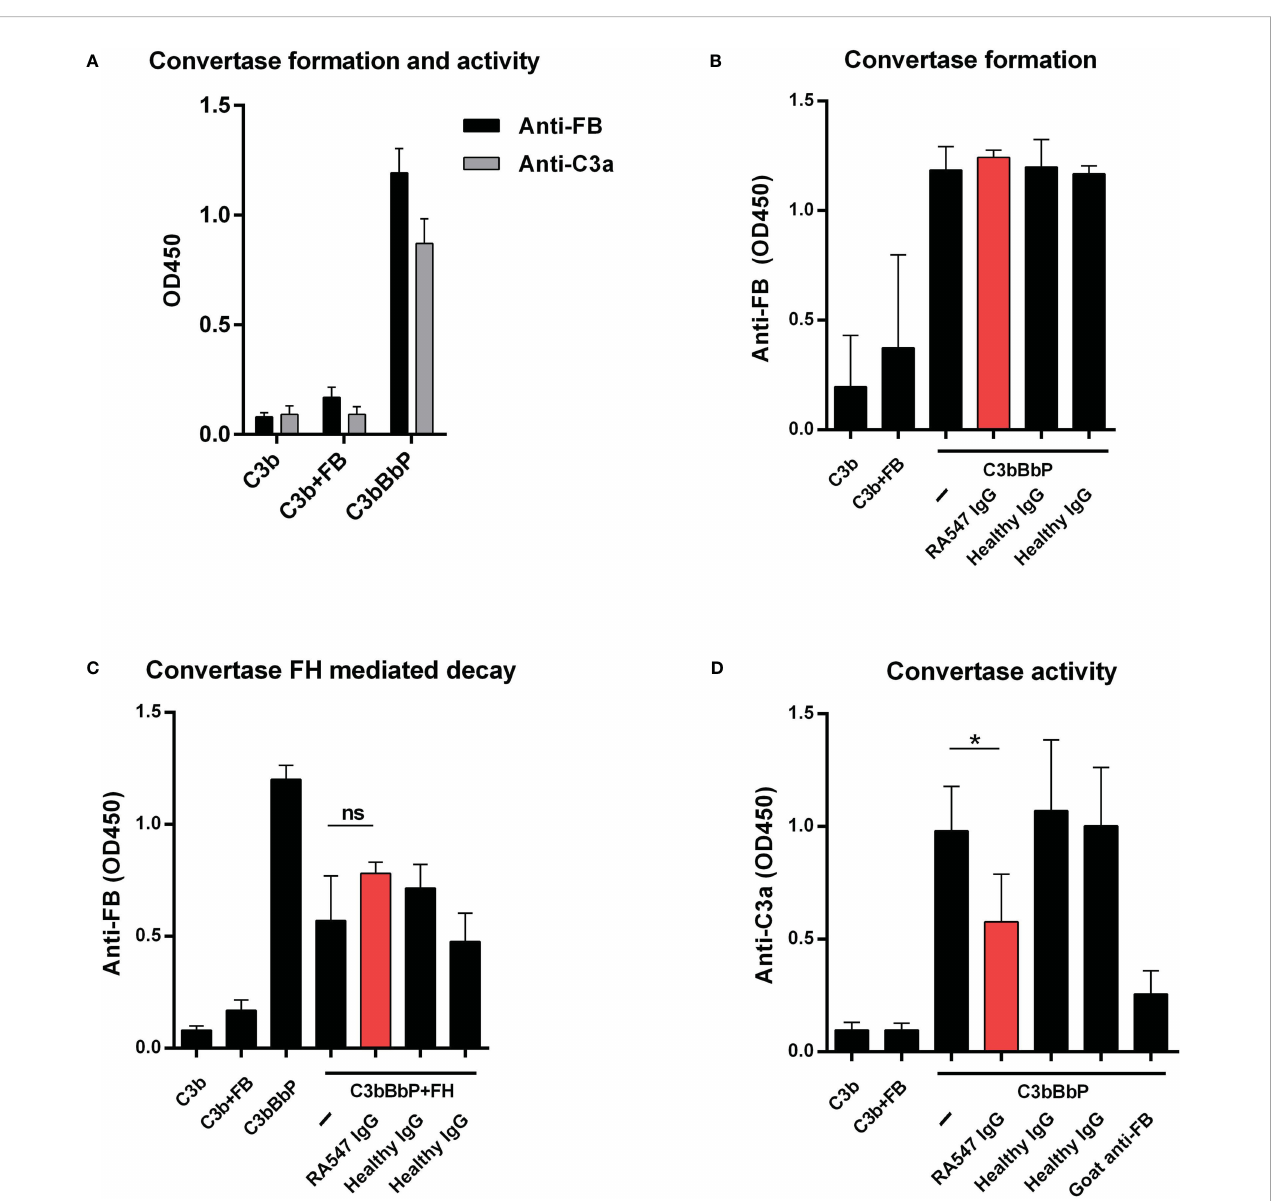
FIGURE 7 Effect of the patient ’ s IgG on alternative pathway C3 convertase. (A) Generation of solid phase C3 convertase in microplate wells. We added FB, FD and properdin together to the immobilized C3b and, after incubation, detected the convertase formation by polyclonal anti-FB. To con fi rm the activity of the convertase, C3 was added in the fl uid phase, and we measured the released C3a from the supernatant with commercially available C3a EIA (Quidel). (B) To test the autoantibodies ’ effect on convertase formation, we added the patient ’ s or healthy controls ’ IgG together with FB, FD and properdin to immobilized C3b. The assembly of the convertase was detected with polyclonal goat anti-FB antibody. (C) Autoantibodies had no effect on the FH mediated decay of the C3 convertase. The convertase was incubated with IgG and FH and the remaining convertase was detected with polyclonal anti- FB antibody. (D) To investigate the effect of the patient ’ s autoantibodies on the activity of the convertase, the convertase was incubated with puri fi ed IgG and, after washing, C3 was added. Supernatants were collected and the C3 cleavage product C3a was measured using C3a EIA. Data are mean ± SD of three (A, C, D) or two (B) independent experiments. * p <0.05, One-Way